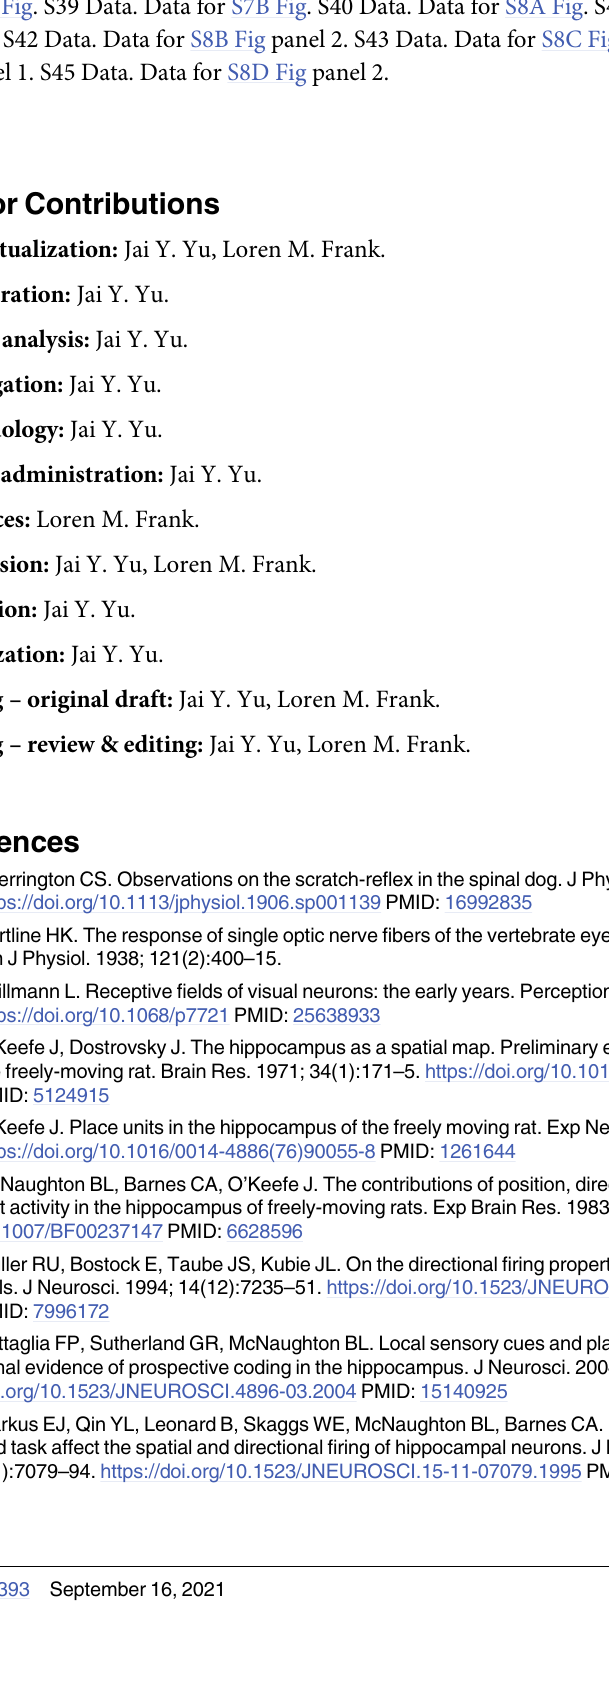
S4B Fig. S30 Data. Data for S5B Fig. S31 Data. Data for S6A Fig panel 1. S32 Data. Data for S6A Fig panel 2. S33 Data. Data for S6A Fig panel 3. S34 Data. Data for S6A Fig panel 4. S35 Data. Data for S6B Fig. S36 Data. Data for S6D Fig. S37 Data. Data for S6E Fig. S38 Data. Data for S7A Fig. S39 Data. Data for S7B Fig. S40 Data. Data for S8A Fig. S41 Data. Data for S8B Fig panel 1. S42 Data. Data for S8B Fig panel 2. S43 Data. Data for S8C Fig. S44 Data. Data for S8D Fig panel 1. S45 Data. Data for S8D Fig panel 2.